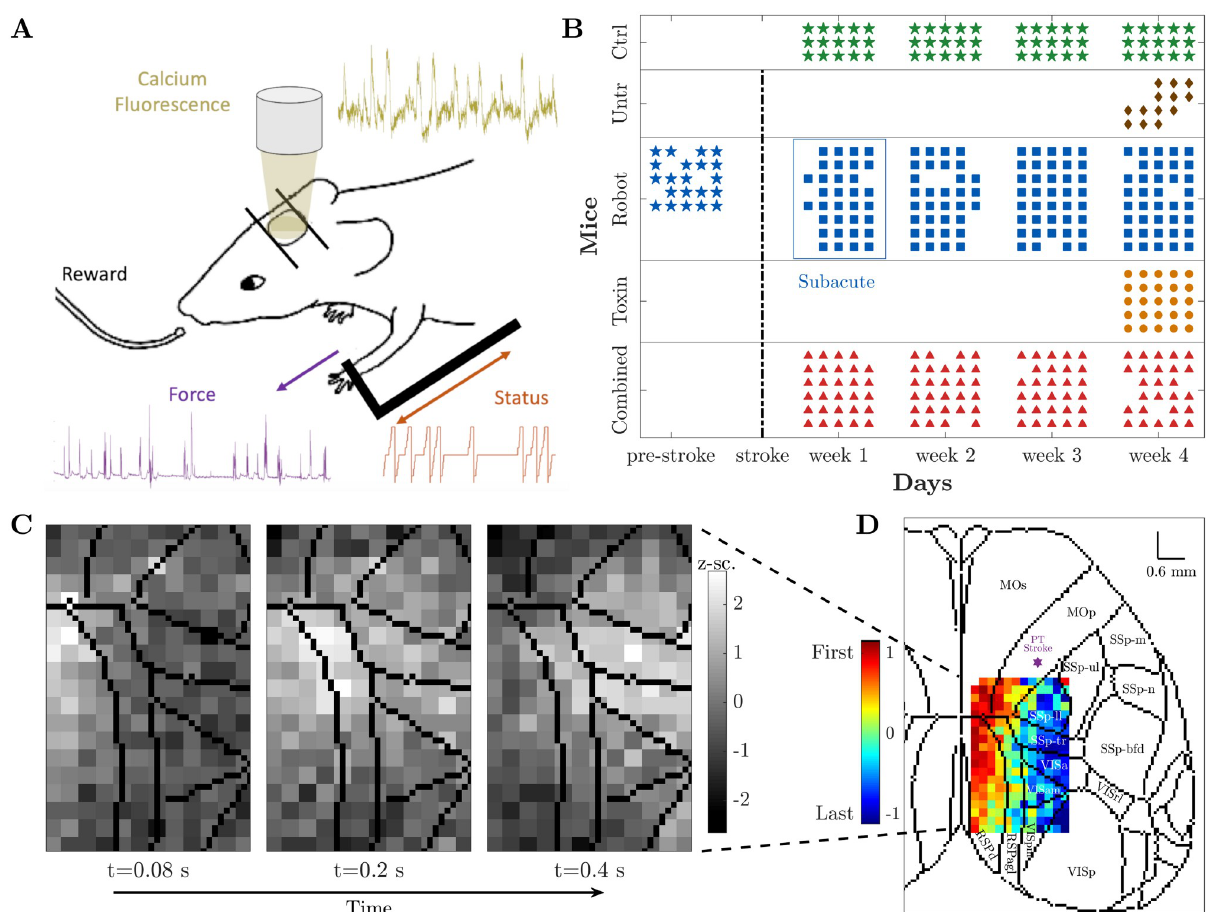
Fig 1. Experimental set-up and data collection. (A) Motor-training of mice was performed on the M-Platform, which uses a movable robotic slide for a retraction movement of the left forelimb. Motor activity was monitored via the discrete status of the slide (orange) and the force applied by the mouse to the slide (purple). Meanwhile, the cortical activity (yellow) was recorded using wide-field calcium imaging. (B) Recording schedule for each mouse per day. The control (green) and combined treatment (red) group performed four weeks of daily training; for the robot (blue) group we additionally recorded one week before stroke induction (typically five sessions per week). Untreated (brown) and toxin (orange) groups only performed one week of daily training starting four weeks after the lesion. Star symbols refer to the healthy condition. Days of recording move along the horizontal axis, while the vertical axis corresponds to mice divided per group. (C) Calcium imaging sequence of cortical activation, superimposed on contours of brain regions according to the standard atlas. (D) Propagation pattern, from leader (red) to follower (blue), of the event depicted in (C). Color coding is based on the SPIKE-order (for details see section “SPIKE-order” in “Materials and Methods” (Supplementary Materials)). For a complete list of brain regions and their acronyms see S1 Fig.